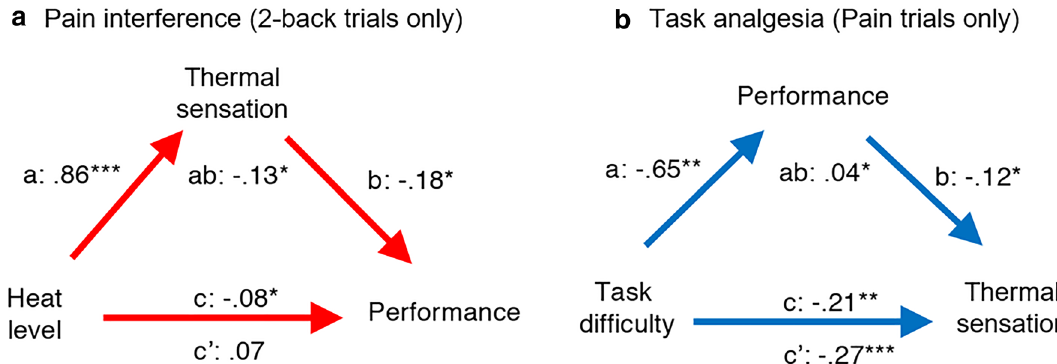
Figure 3. First-level mediation models of the effects of task difficulty on sensation and of heat level on task performance. In red ( a ), mediation of the effect of heat level on task performance by thermal sensation for 2-back trials only. In blue ( b ), mediation of the effect of task difficulty on reported sensation by task performance for Pain trials only. a, b, c, and c’ are mean standardized regression coefficients for the illustrated relationships; *** p < 0.001, ** p < 0.01, * p <